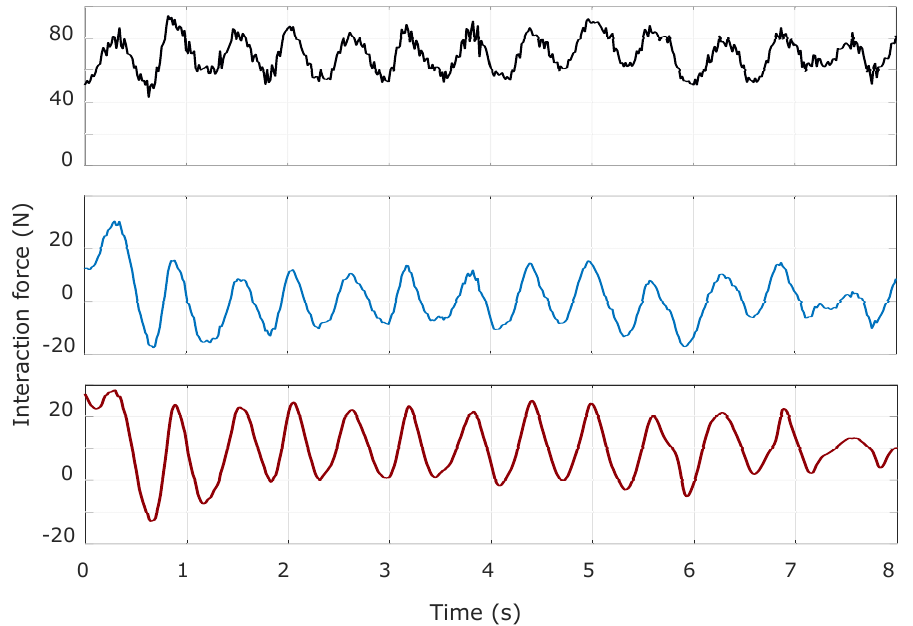
Figure 1. Interaction force along vertical direction. Black line represents the raw data of the interaction force, blue line represents the signal after BMFLC, and red line represents the reconstructed signal of the